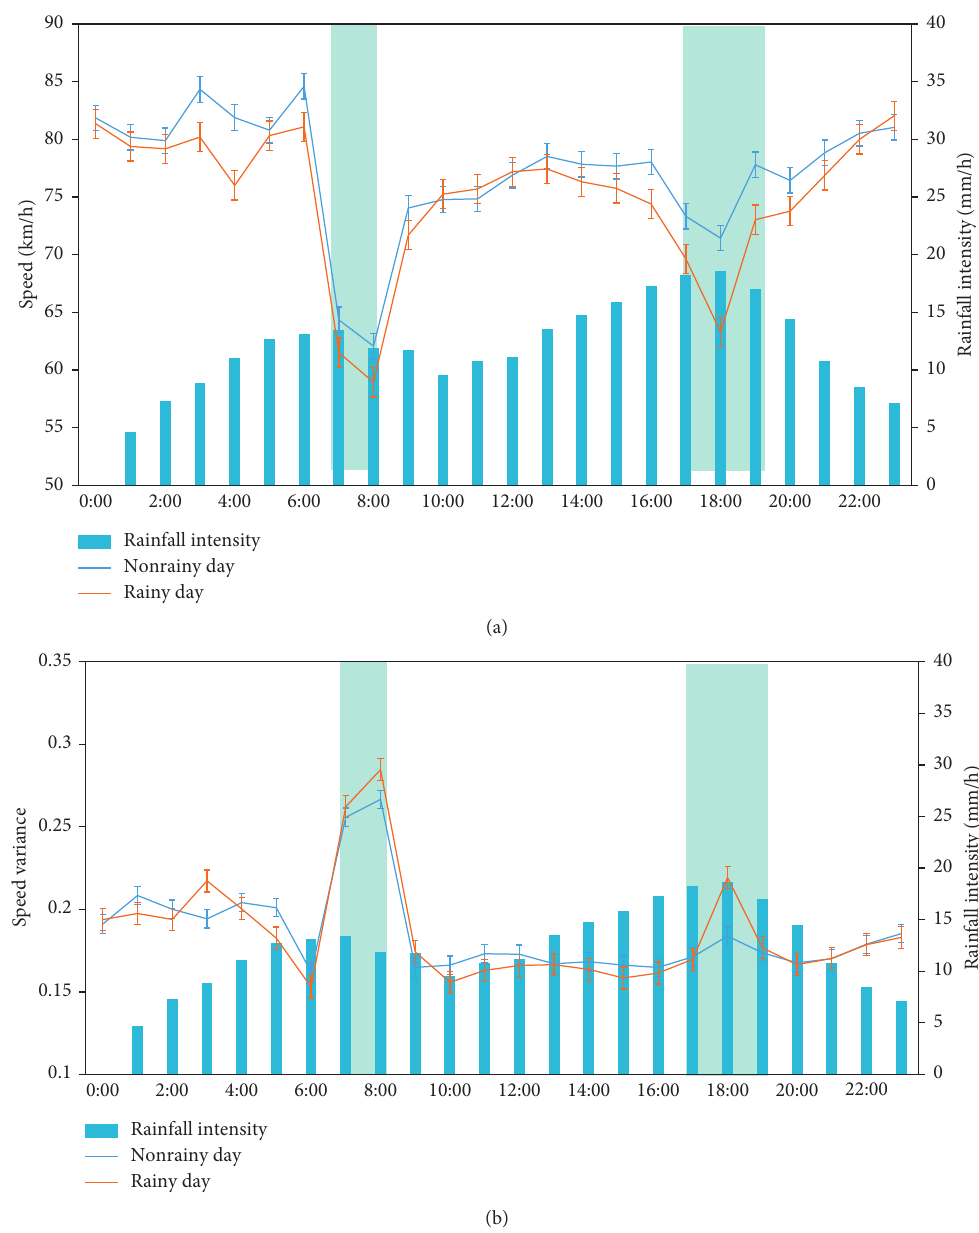
Figure 3: The impact of rainfall intensity on the travel speed and travel speed variance.